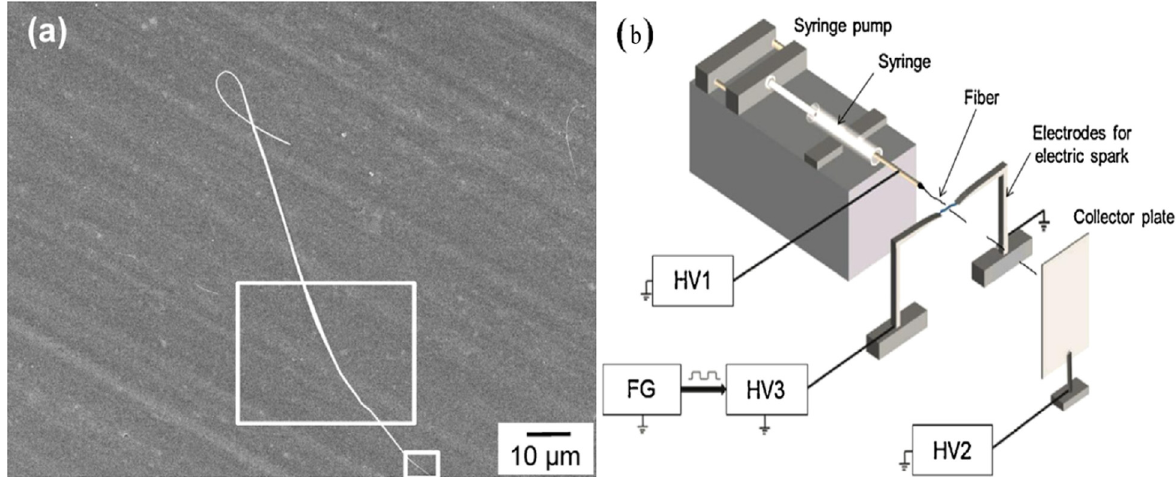
Figure 3: ( a ) Short nano fi ber and ( b ) schematic of the electric spark mechanism utilized for obtaining short nano fi ber [ 18 ] ; Copyright 2013, reproduced with permission from Elsevier